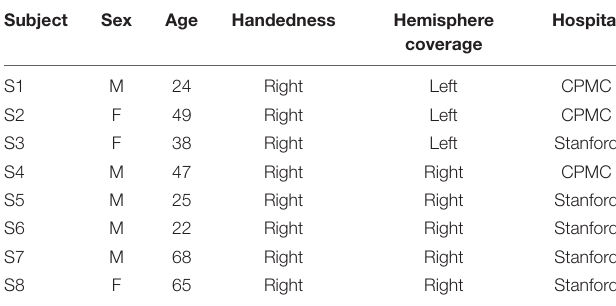
TABLE 1 | Electrocorticographic (ECoG)